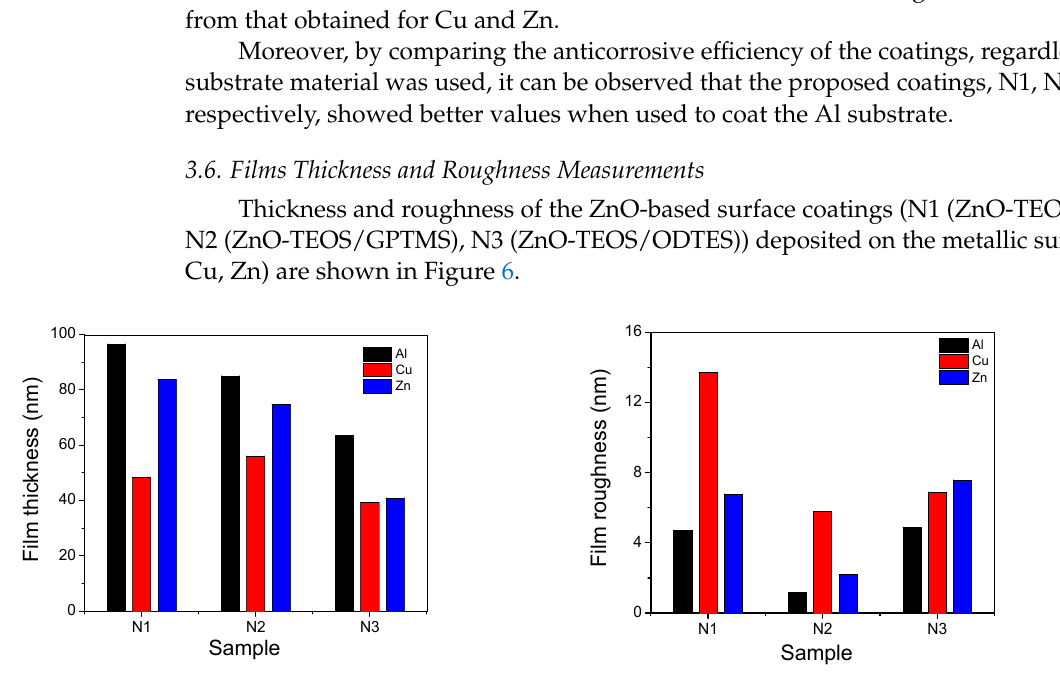
Figure 6. Thickness and roughness of the ZnO-based surface coatings N1 (ZnO-TEOS/OTES), N2 (ZnO-TEOS/GPTMS) and N3 (ZnO-TEOS/ODTES), deposited on the metallic surfaces (Al, Cu, Zn), determined by the ellipsometric measure- ments.